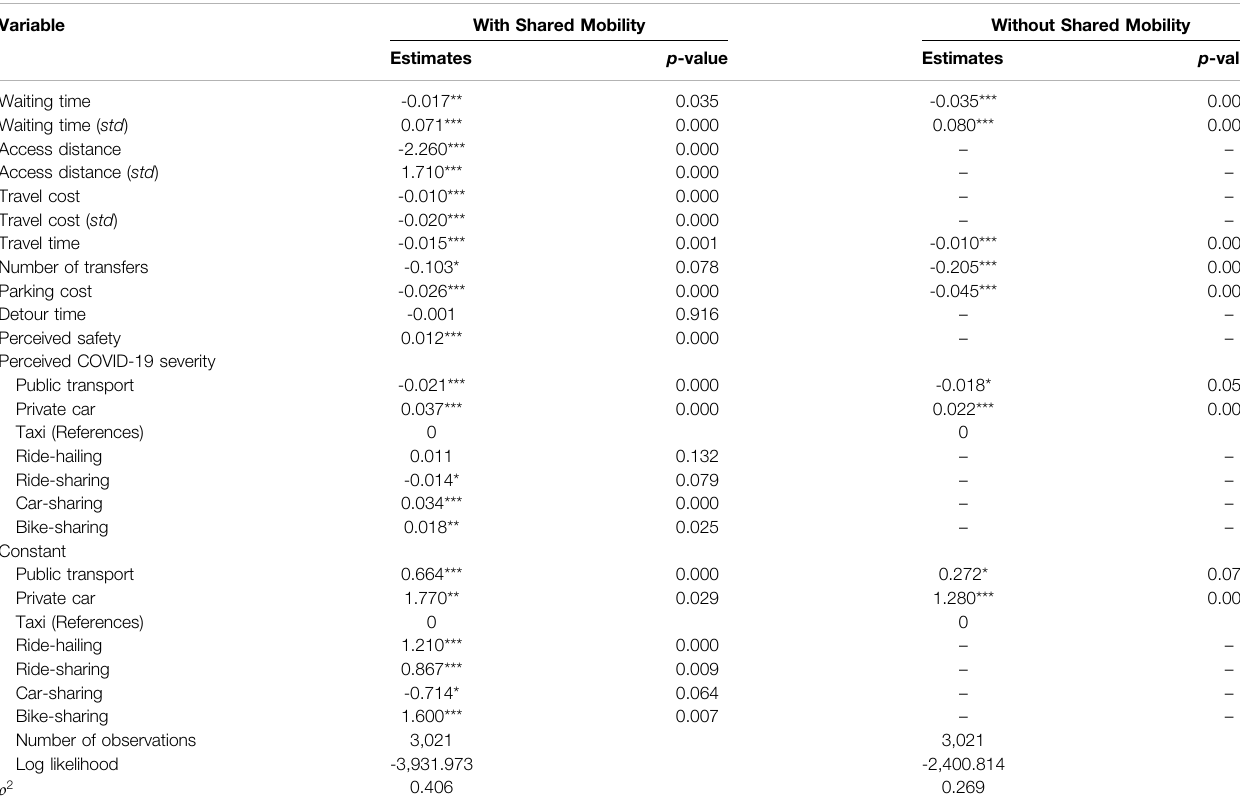
TABLE 5 | Mixed logit model estimation